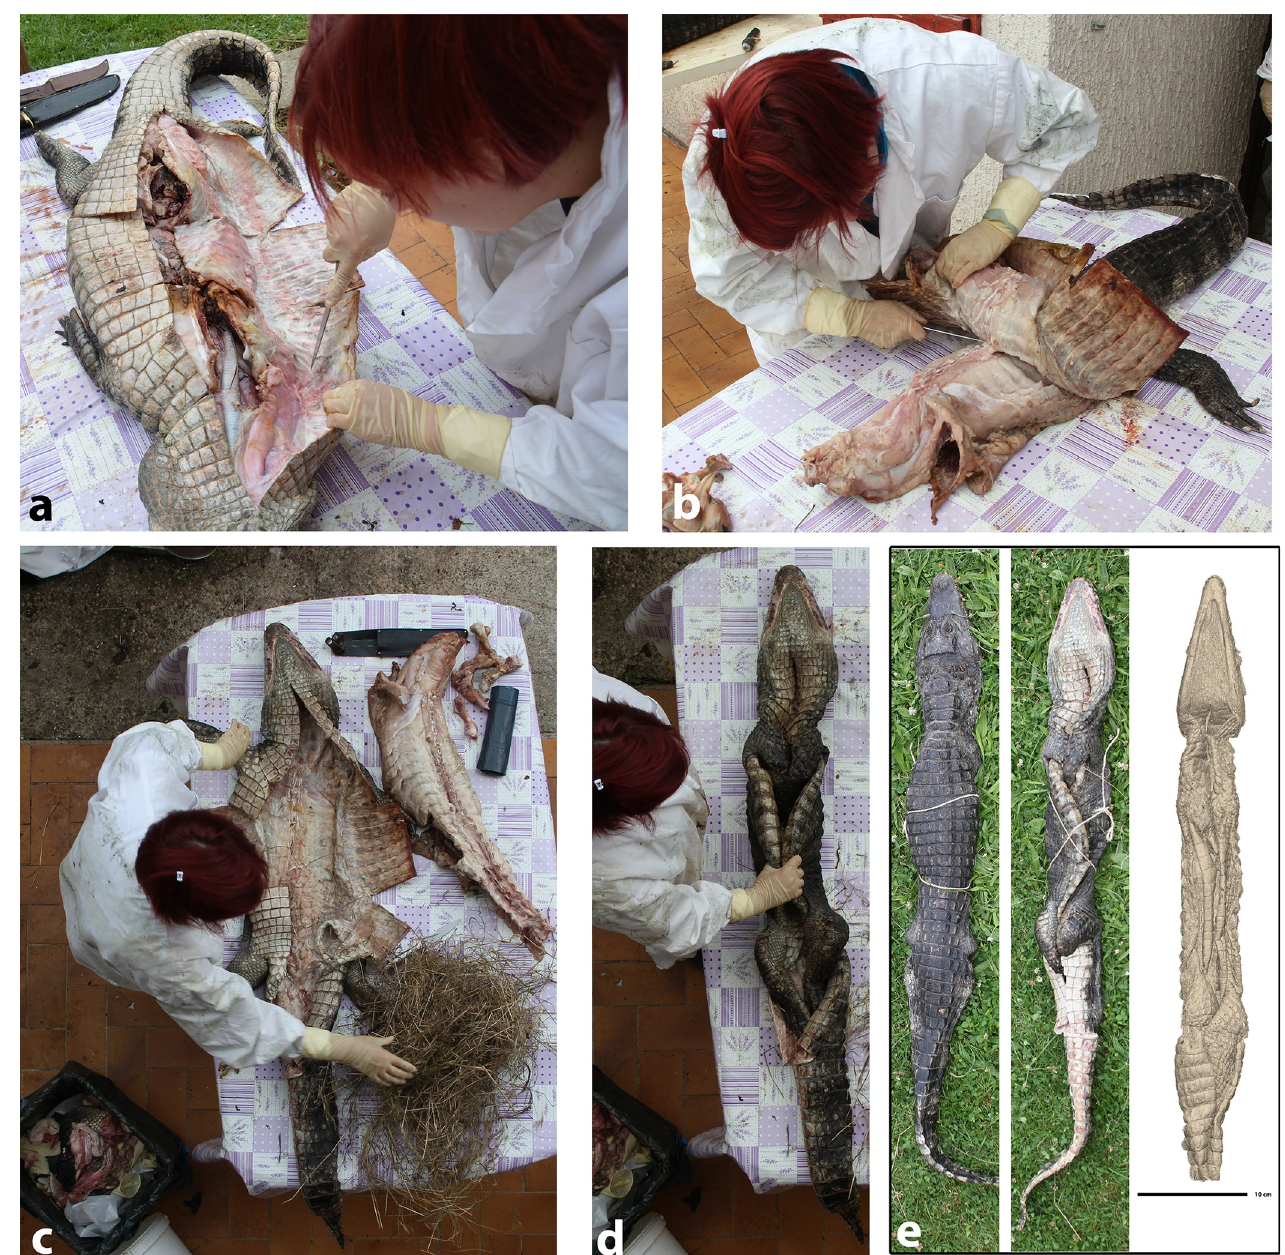
Fig 7. Experimental preparation of a caiman cadaver. a. The skin is separated from all other tissues, b. After separating the skull from the neck, the skin is turned inside out to facilitate its separation over the dorsum and enable evacuation of the limbs, c. The limbs are stuffed with plants (grasses) d. The limbs are tucked inside the skin and the body is “shaped”, e. Comparison between the result of the experiment and the 3D rendering of the genuine Egyptian mummy. Geometry and location of the cut marks can be explained by a single move repeated several times when the bones were not separated after the first cut. The more distal cut marks appear as cracks, which may indicate a percussive action rather than a slicing movement [29]. Multi- ple cut marks in a single bone indicate that the manual digits were severed by repeated cuts at the level to which the metapodal bones could be reached when the skin was reversed as much